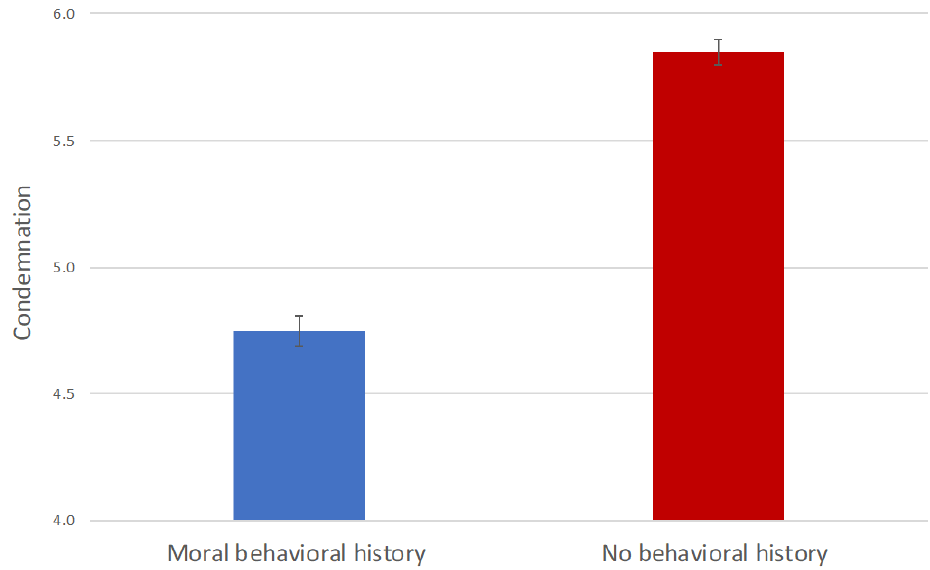
Figure 1. Condemnation of immoral behavior by condition. The error bars represent the standard errors of the means. The data are shown from the neutral point four of the Condemnation Scale.